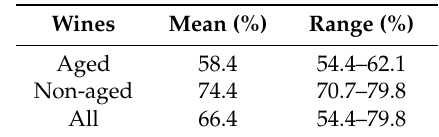
Table 3. Angiotensin I converting enzyme inhibitory activity of melanoidins at a concentration of 2 mg · mL − 1 isolated from aged and non-aged Commandaria wines. Significant differences ( p < 0.05) for aged and non-aged Commandaria wines were